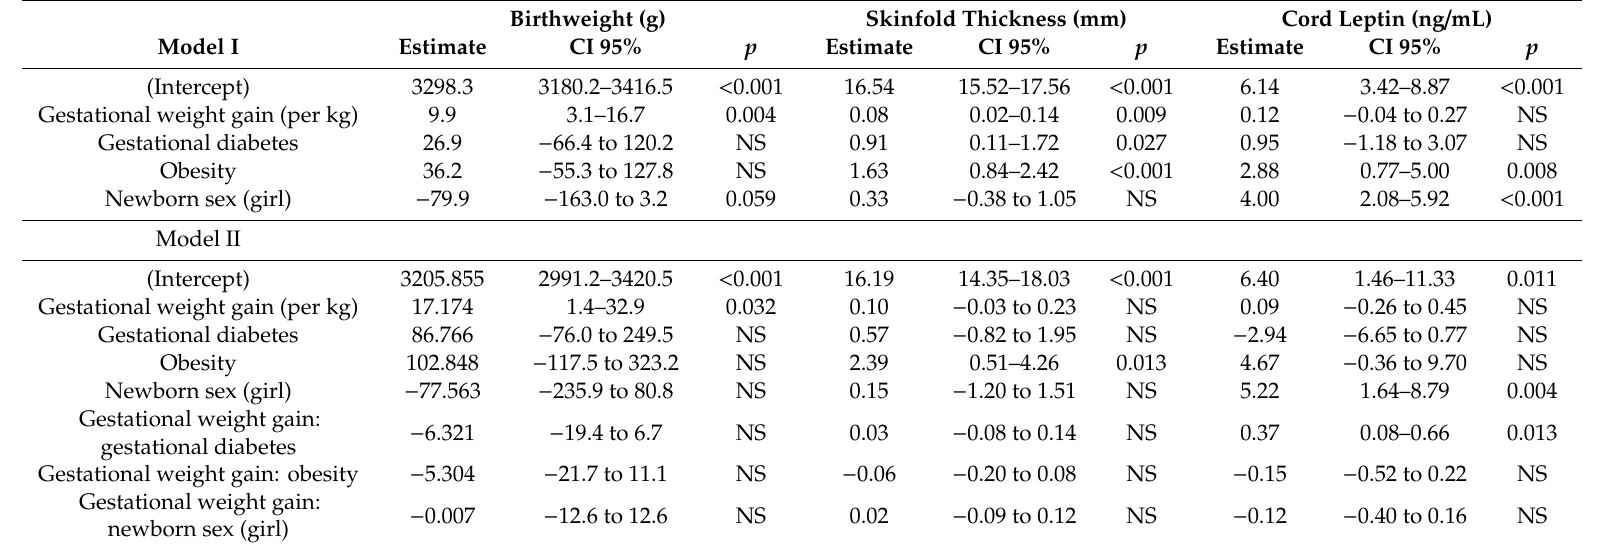
Table 2. Contribution of total gestational weight gain on birth weight, skinfold thickness, and cord leptin